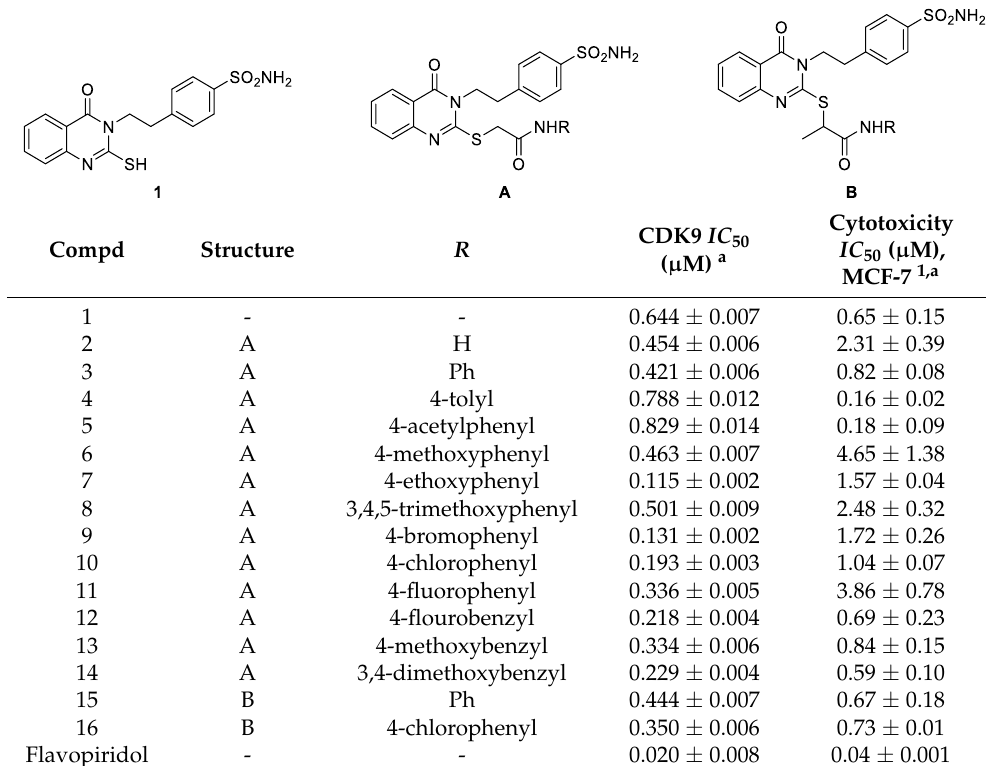
Table 1. Structures of compounds 1 – 16 and their biological activity. Table 1 . Structures of compounds 1 – 16 and their biological